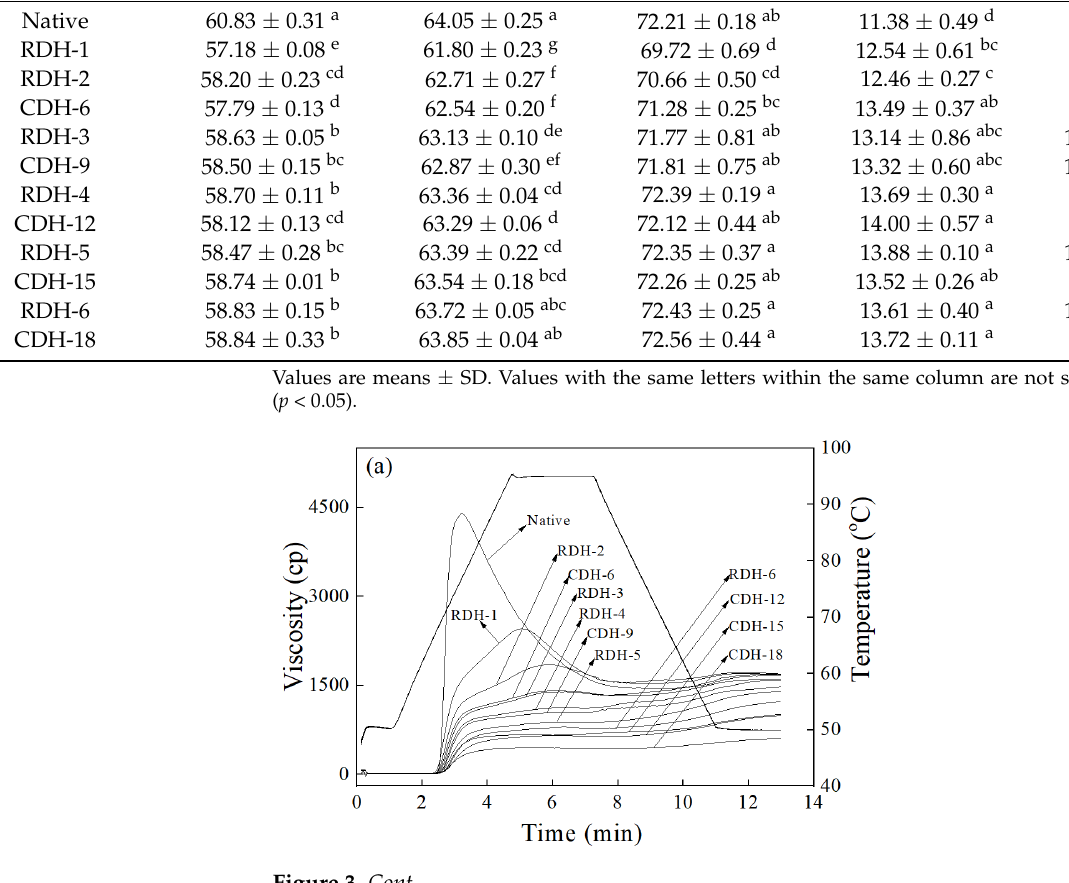
Figure 3. Pasting properties ( a ), DSC thermograms ( b ) and RDS, SDS and RS ( c ) of the native, CDH- and RDH-treated potato starch samples.